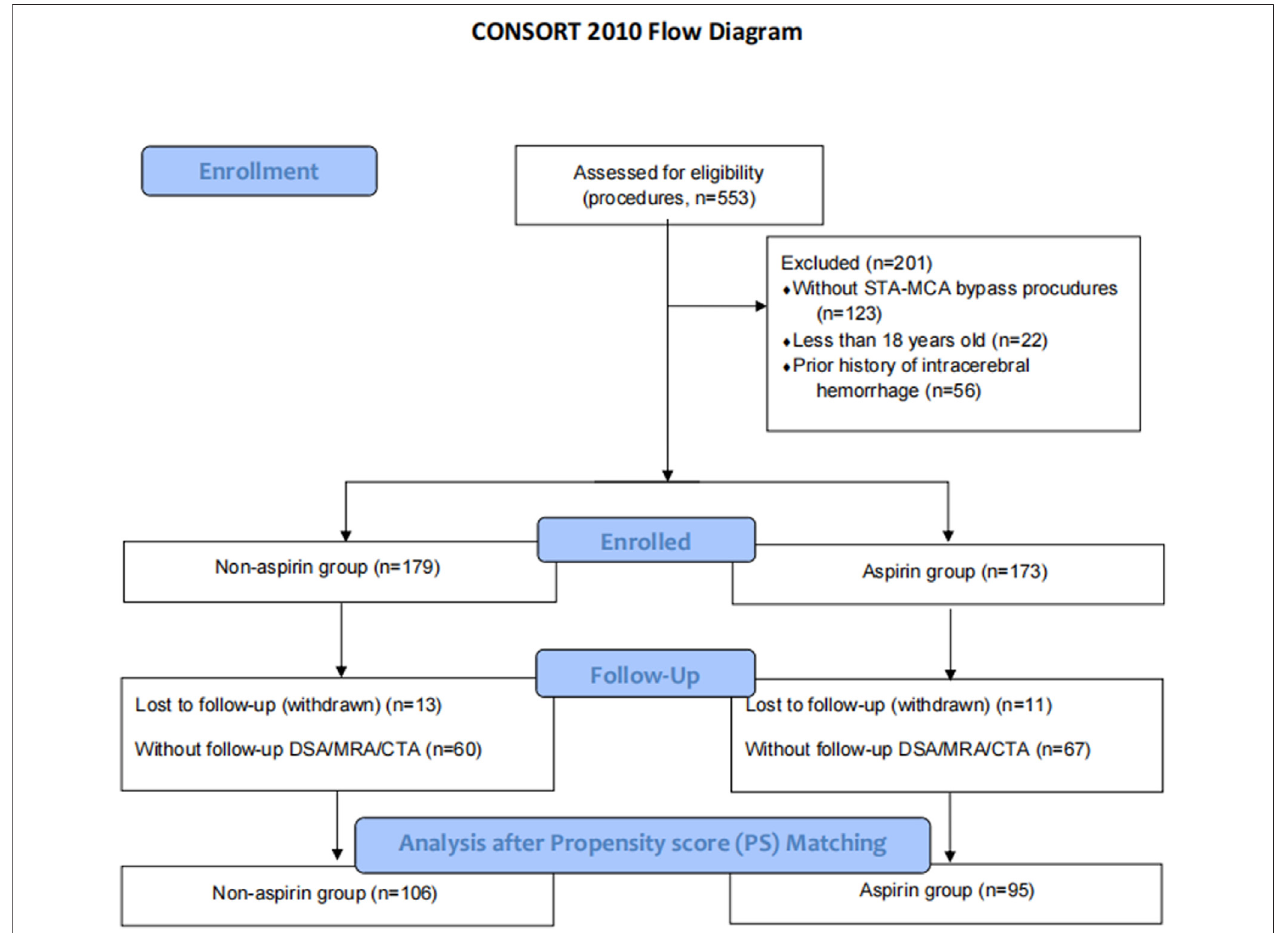
FIGURE 1 | Flow diagram of the progress through the